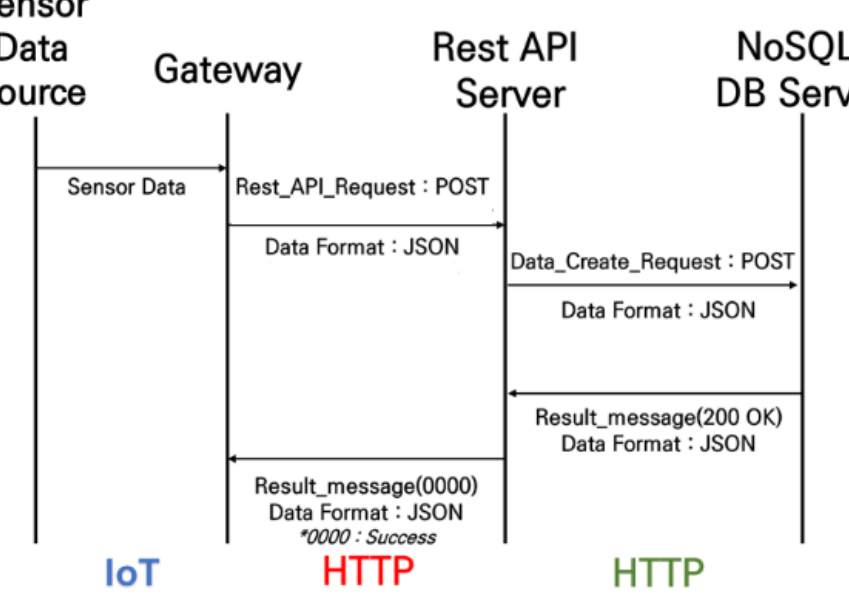
Figure 5. REST API protocol.